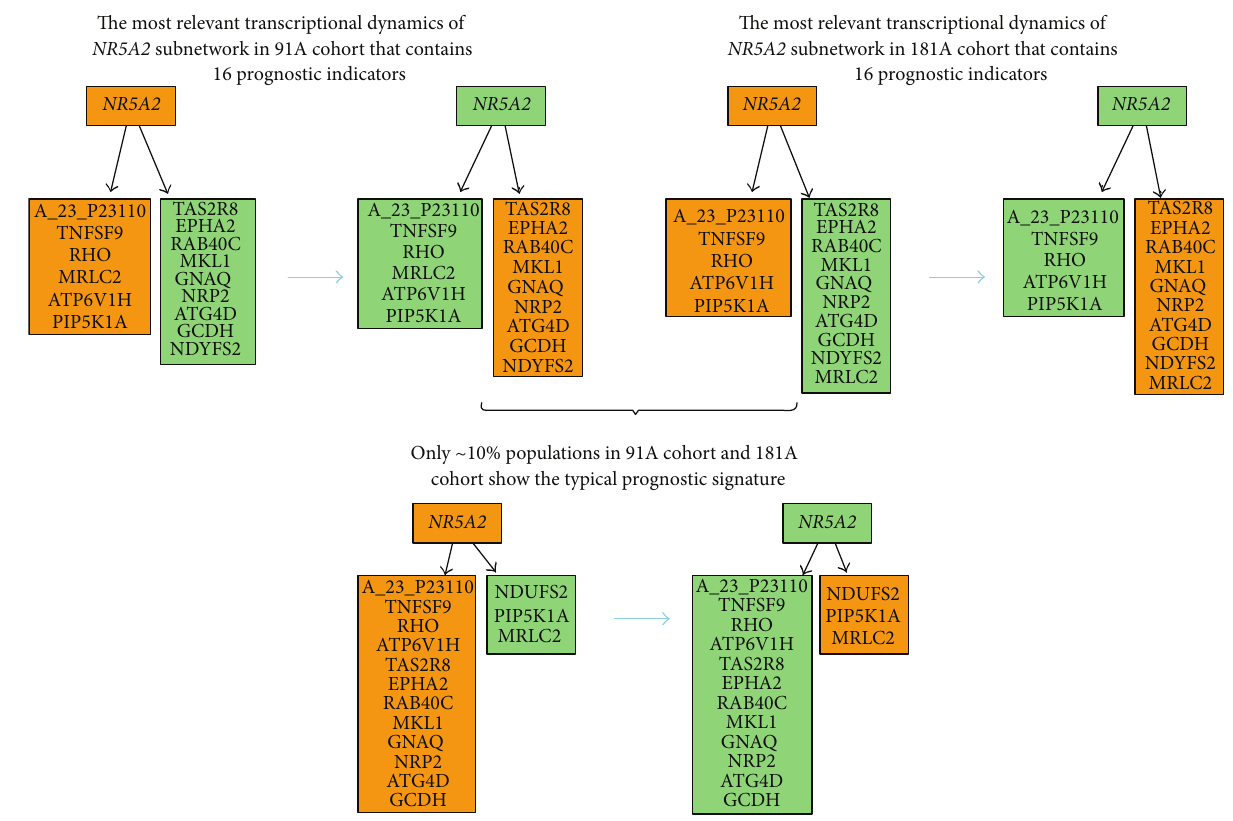
Figure 6: Inferred subnetwork of NR5A2 in regulating prognostic predictors during tumor progression. Tumor progression is predicted to be controlled by an ER 𝛼 independent NR5A2 -mediated mechanism. The deviation between prognostic relevant subnetwork and the inferred subnetwork of NR5A2 is due to differential data distribution among tumor samples. This diagram demonstrates that the supervised network analysis can identify signatures conditioning poor prognosis possibly driven by NR5A2 in ∼ 10% studied